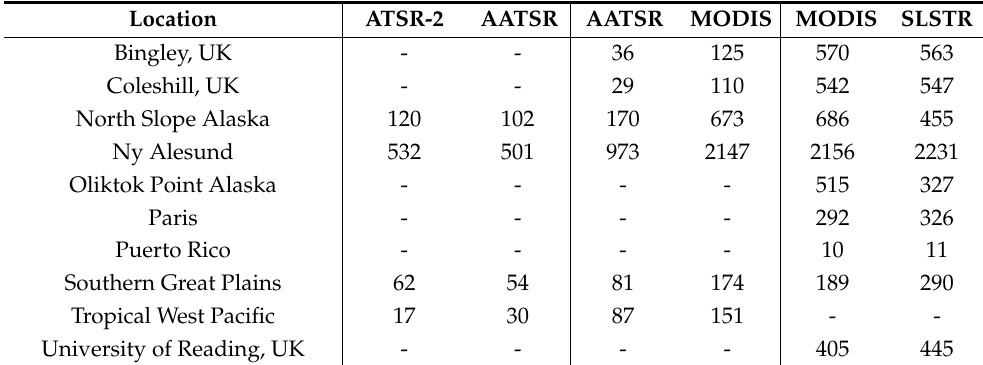
Table 8. Number of cloudy ceilometer observations compared when calculating the hit rate for overlapping data between different sensors: ATSR-2 and AATSR, AATSR and MODIS, MODIS and SLSTR.